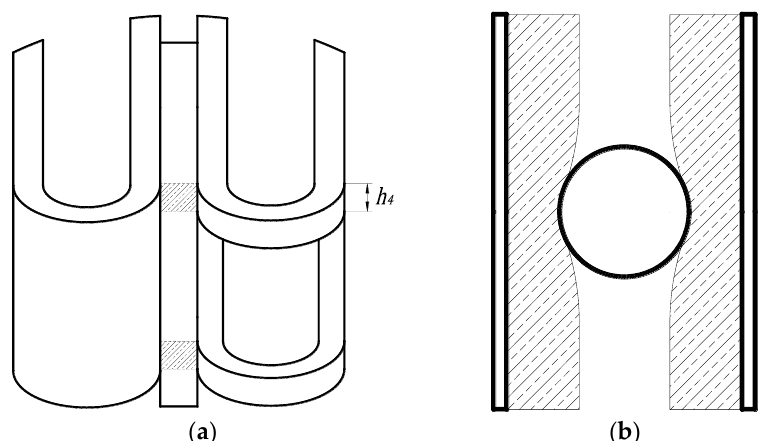
Figure 10. Stalk clamping state of rape shoots: ( a ) overall status; ( b ) local status.